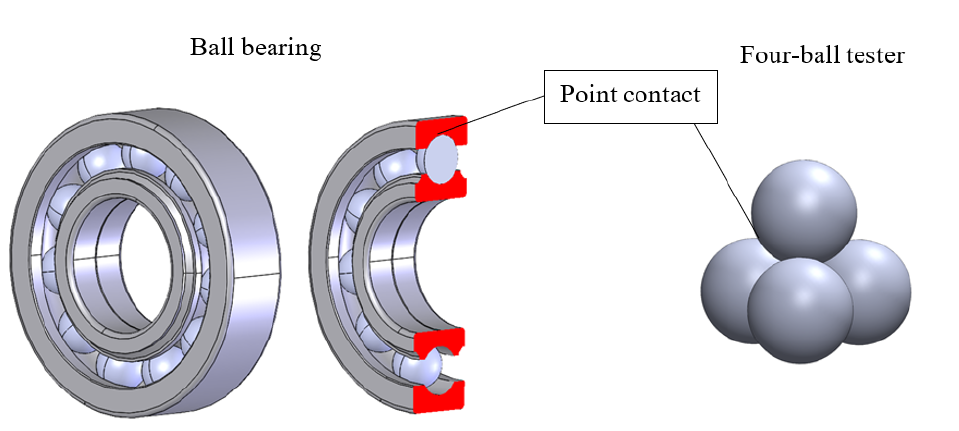
Figure 3. ( Left ) Point contact in a real ball bearing. ( Right ) Idealization of a point contact in a four-ball